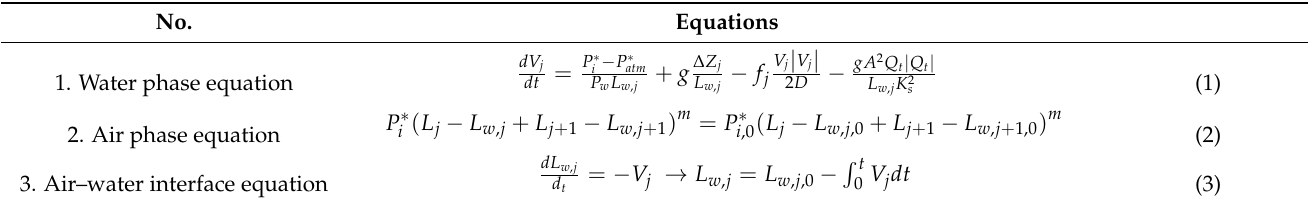
Table 1. Equations for an irregular pipeline system.